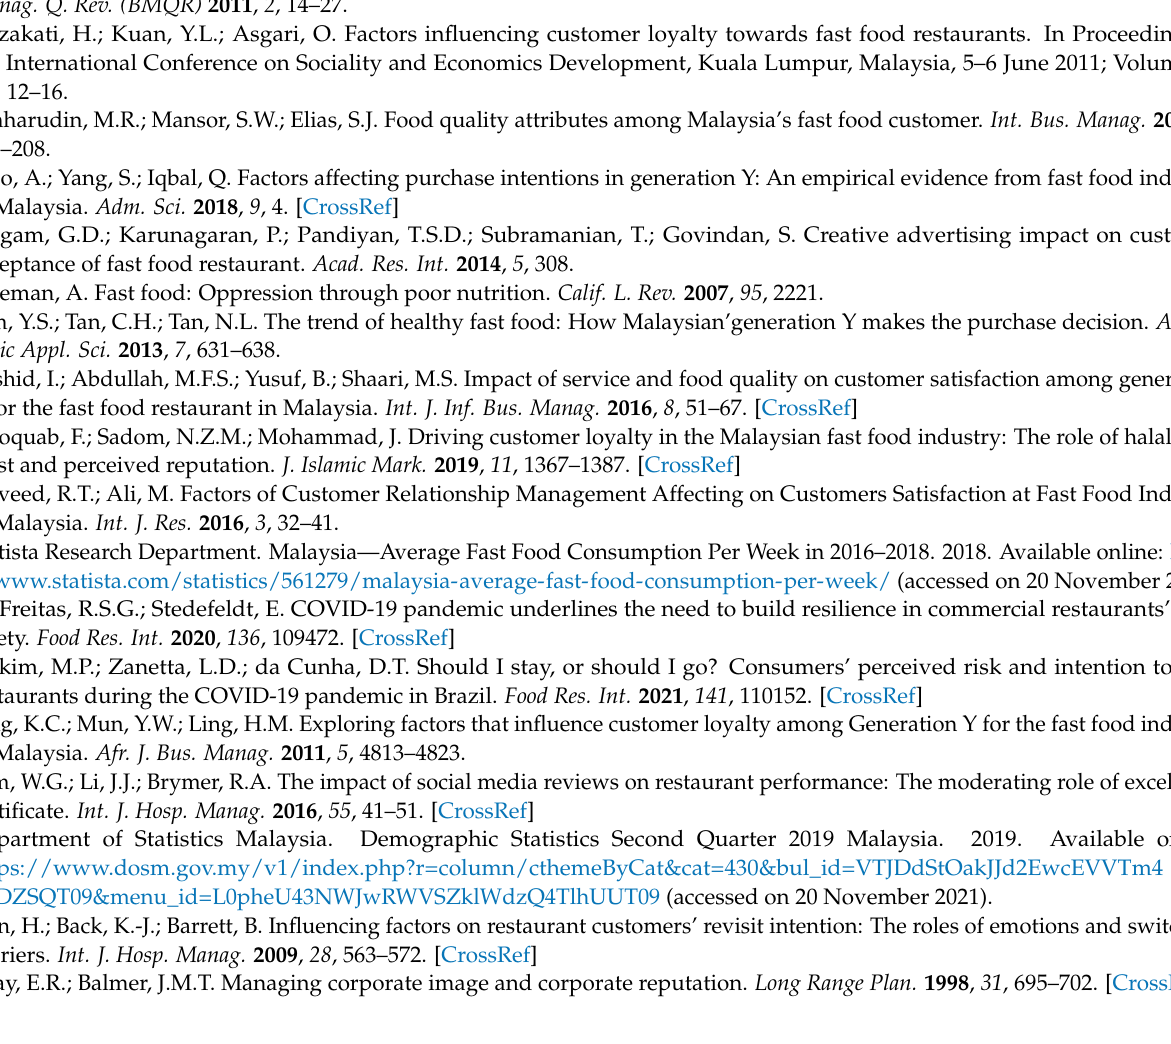
any given week, Figure 5: Tree map showing the weights of main and sub-attributes, Figure 6: Per- formance scores of FFRs, Figure 7: Overall image score of each FFR. Available online at https://public. tableau.com/views/FFRImage/Figure1?:language=en-US&:display_count=n&:origin=viz_share_link (accessed on 4 February